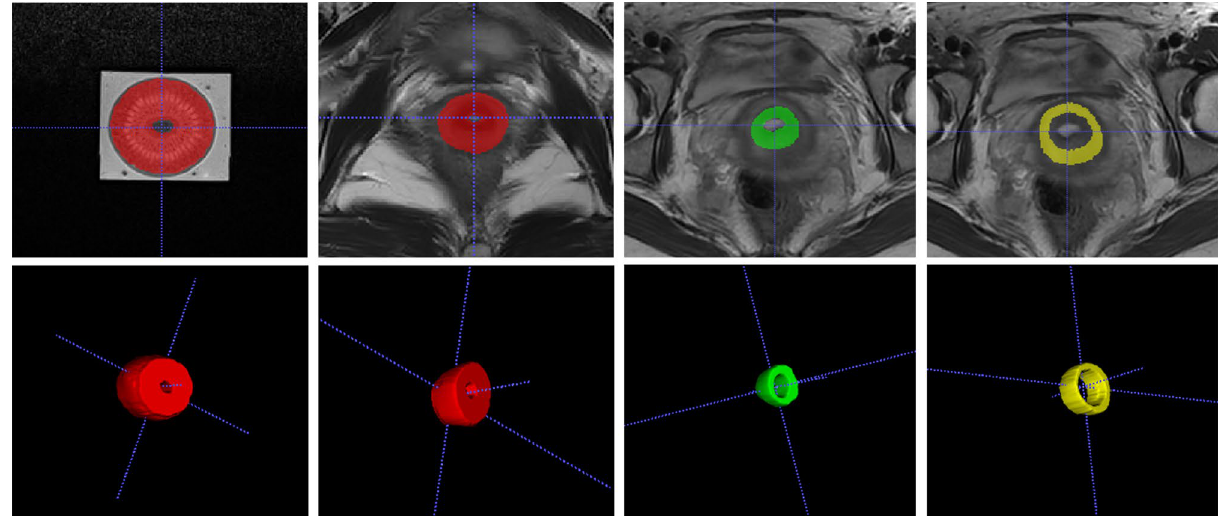
Figure 5. Delineation of three-dimensional regions of interest. Note Three-dimensional regions of interest of the kiwi covered almost the whole pulp of the central 5 slices of axial images except the skin and the central hypo-intensity region ( a ). To segment the normal cervix of volunteers, the whole cervix ( b ) including the endocervix, the junctional zone and the outer muscular layer was selected and liquid in cervical canal was excluded. For all leiomyoma patients enrolled in this study, the junctional zone ( c ) and the outer muscular layer ( d ) of their healthy cervix were delineated